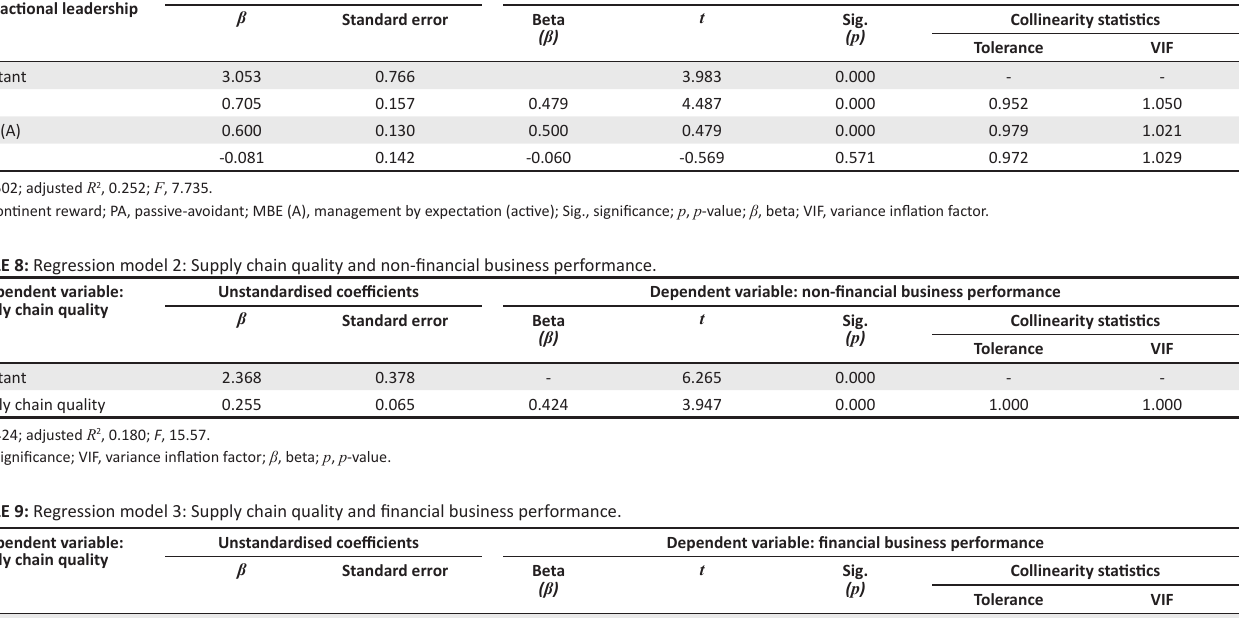
TABLE 7: Regression model 1: Transactional leadership and supply chain quality. Independent variables: transactional leadership